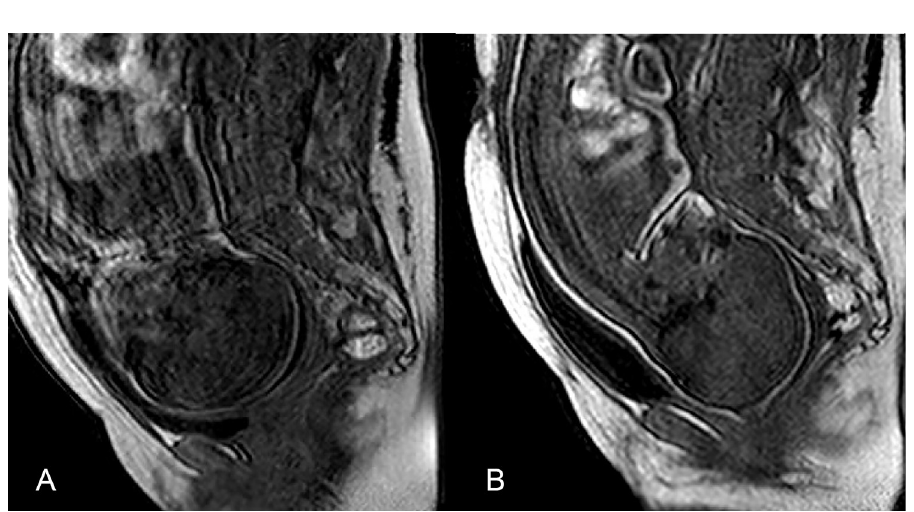
Fig 3. Median sagittal plane MRI before and during labor in patient 5. (a) No fetal head molding was observed before labor. The maternal coccyx was concave anteriorly, and the perineal raphe horizontal.; (b) The fetal head is shown in the middle pelvic brim during the second stage of labor. The fetal presentation has turned to occipito-pubic, the coccyx has tipped backward, and the perineal raphe has assumed a vertical position. The fetal head has typical “sugarloaf molding”. This head molding was not observed after birth.